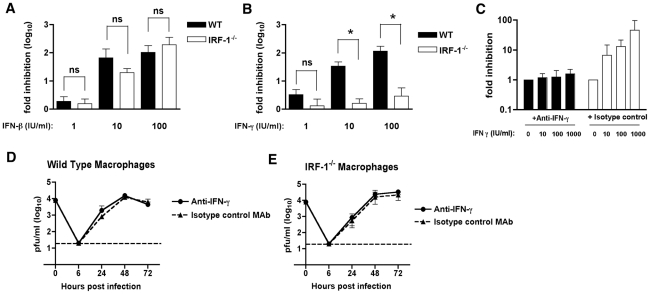
The relationship between IFN-γ and IRF-1 in Mφ.
A-B.The antiviral effects of exogenous IFN-β or IFN-γ in Mφ. Wild type or IRF-1
-/- Mφ were pretreated overnight with the indicated amount of (A) IFN-β (1 to 100 IU/ml) or (B) IFN-γ (1 to 100 IU/ml). Subsequently, cells were infected with WNV at an MOI of 0.01 and one-day later supernatants were harvested and titrated for viral infection. The data are expressed as the log10 fold inhibition relative to the no IFN treatment control. Asterisks indicate differences that are statistically significant (*, P<0.05). C-E. The antiviral effect of IRF-1 in macrophages is independent of IFN-γ expression. C. The H22 MAb efficiently neutralizes the antiviral effect of exogenous IFN-γ treatment. Mφ were pretreated with the indicated concentrations of IFN-γ in the presence of H22 anti-IFN-γ or an isotype control MAb. Subsequently, cells were infected with WNV at an MOI of 0.01 and one-day later supernatants were harvested and titrated for viral infection. The data are expressed as the log10 fold inhibition relative to the no IFN treatment control. (D) Wild type or (E) IRF-1
-/- Mφ were infected at an MOI of 0.01 in the presence of H22 anti-IFN-γ or an isotype control MAb. Virus production was evaluated at the indicated times by plaque assay. Values are an average of triplicate samples generated from three independent experiments, and error bars represent the SD. Differences were not statistically significant.